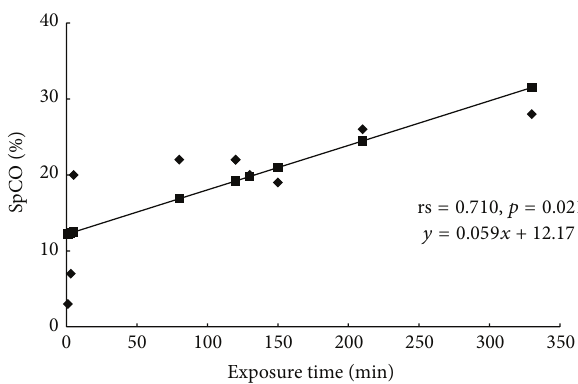
Figure 1: CO-Hb levels (SpCO) measured at the site of CO poisoning using a pulse CO-oximeter versus the CO exposure time.